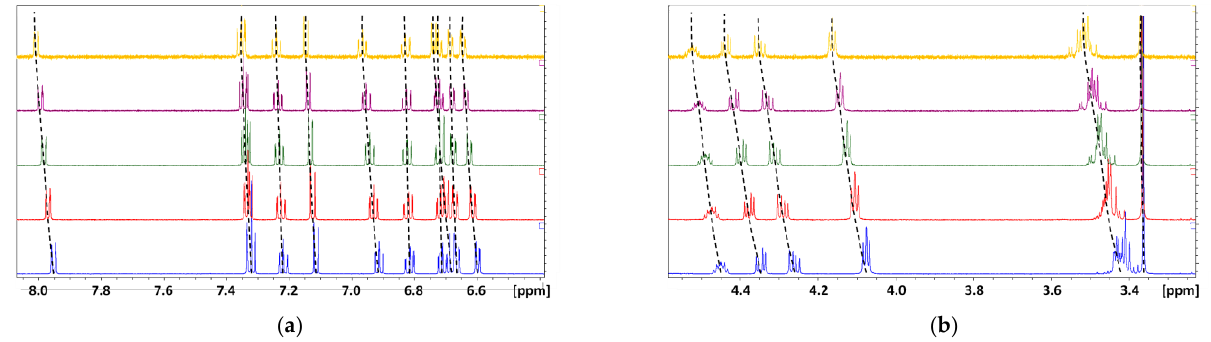
Figure 3. Stacking of partial 1 H NMR spectra (600 MHz, 298 K) obtained from carvedilol solutions (0.1 M acetate-buffered D 2 O) at a concentration of 5 mM ( ), 3.5 mM ( ), 2.5 mM ( ), 1.5 mM ( ) and 0.5 mM( ); ( a ) the aromatic moieties; ( b ) the aliphatic moiety.